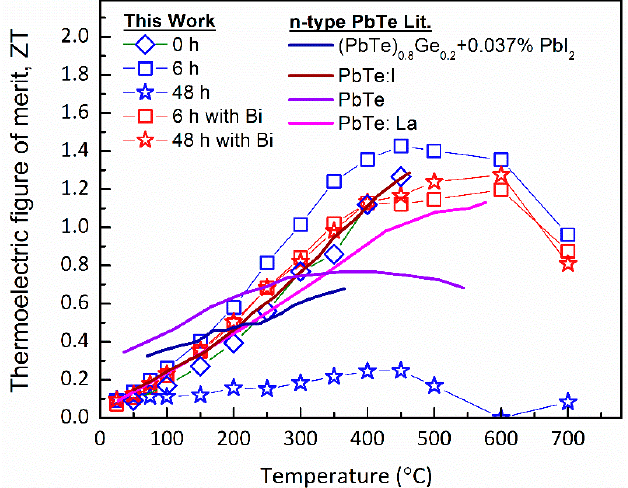
Figure 7. The temperature dependent thermoelectric figure of merit, ZT, evaluated for the hot-pressed (HP) series of specimens aged at 380 °C for 0 (diamonds), 6 (squares), and 48 h (stars) for the Bi-free (blue symbols) and Bi-alloyed (red symbols) materials. Selected data for n-type PbTe from literature are plotted for comparison.